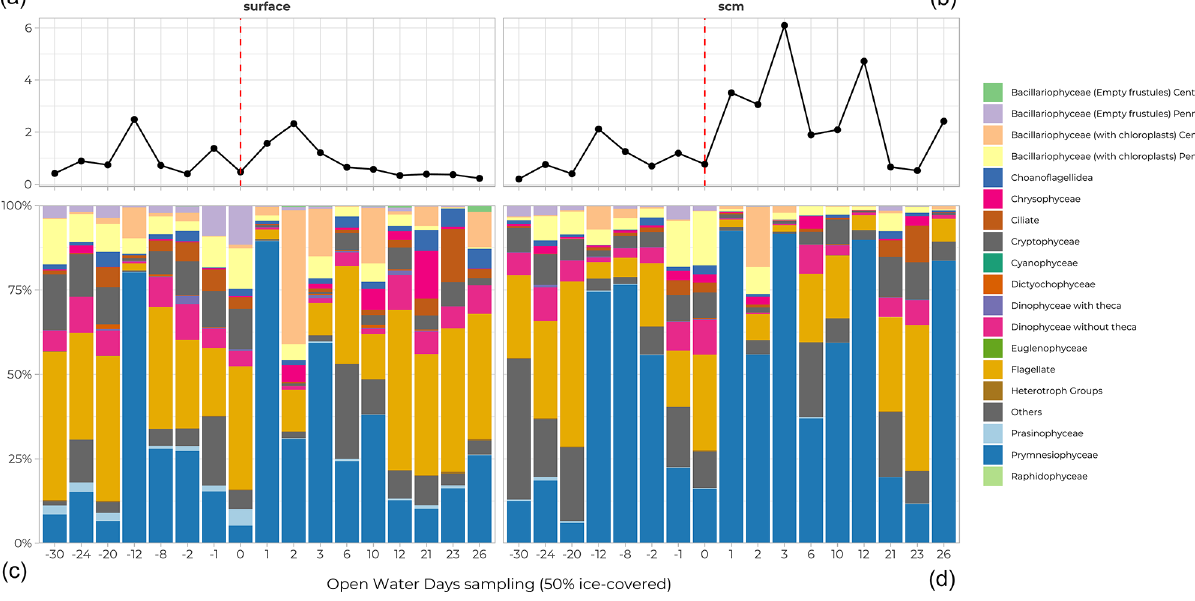
Figure 12. Relative abundance (%) of main phytoplankton groups (coloured bars) at the surface (a, c) and at the subsurface chlorophyll maximum (SCM; b , d ) for all stations analyzed. Stations are sorted according to their OWD value (Fig. 7); (a) and (b) represent the chlorophyll a concentration (mgm − 3 ) at the relevant depths for each